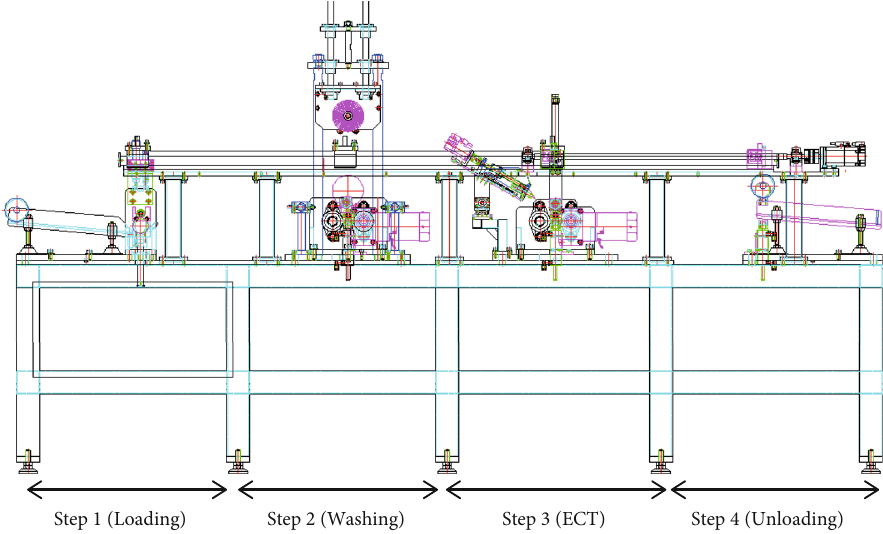
Figure 4: Equipment for washing and nondestructive inspection of stud bolt.